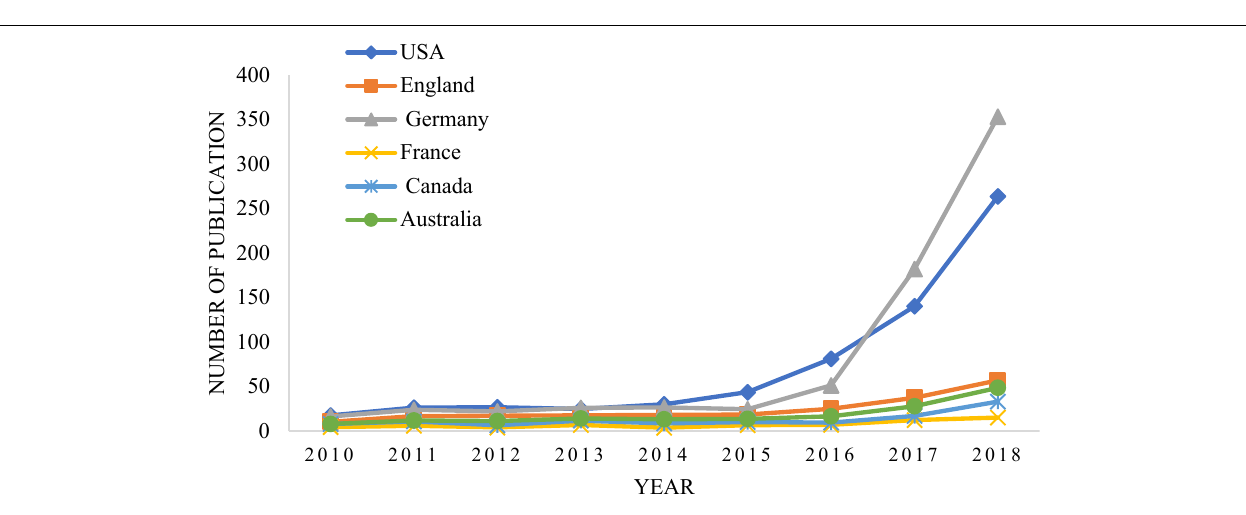
FIGURE 4 | The changing trend of the application of artificial intelligence based on deep learning in the legal field in some western countries from 2010 to